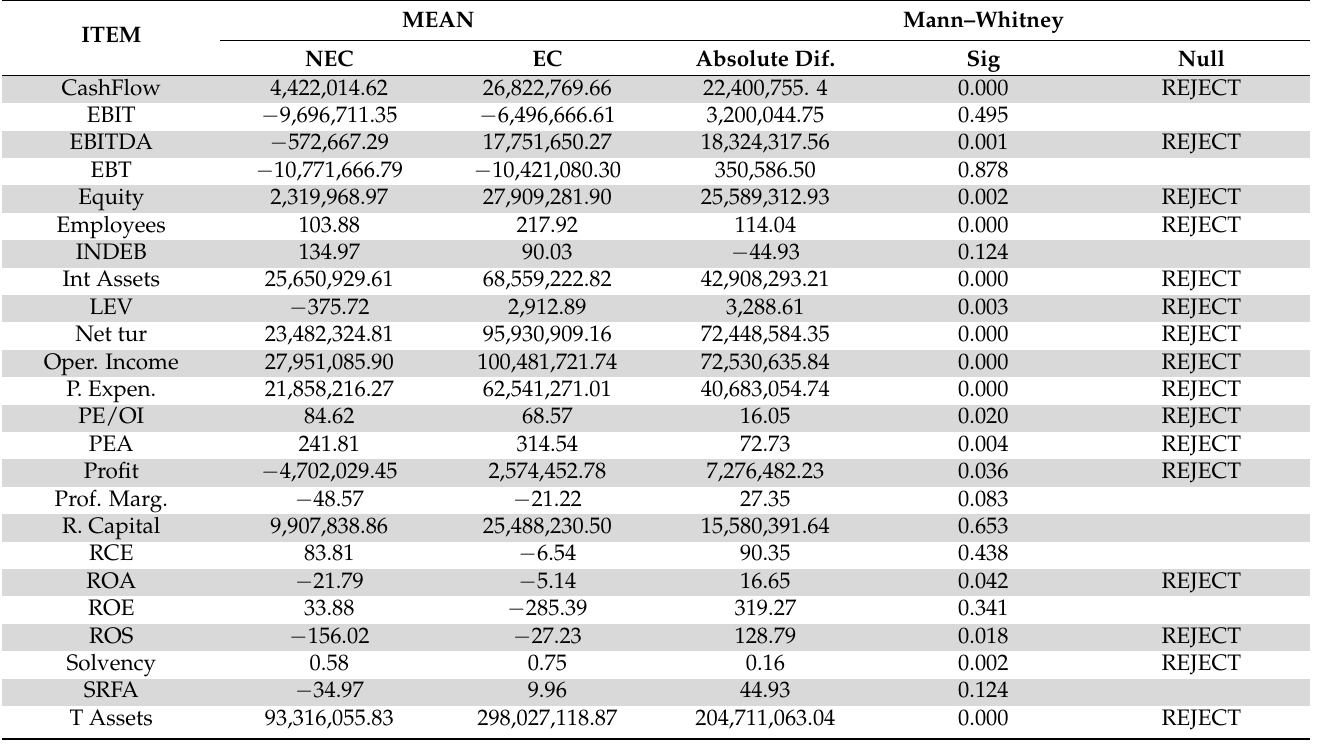
Table 2. Testing financial variables based on participation in European Competitions